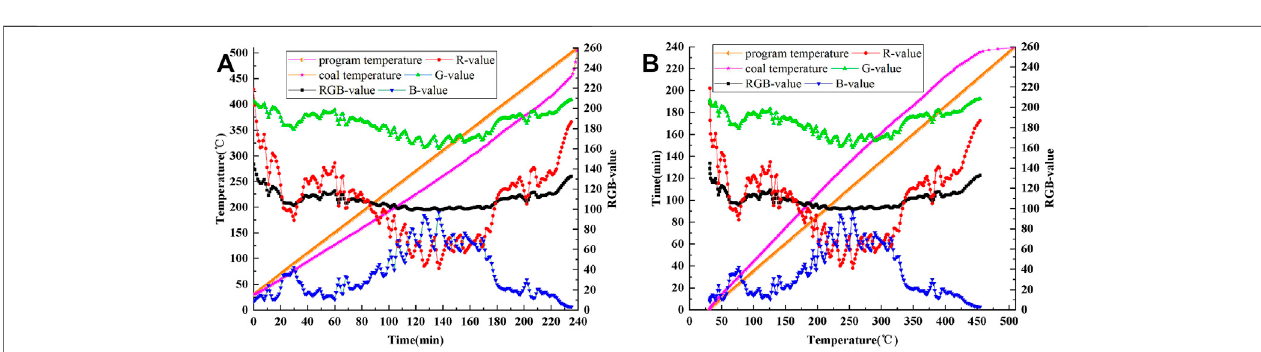
FIGURE 8 | Curves of program temperature, coal temperature and R, G, B, RGB values: (A) time-varying, (B) temperature-varying.